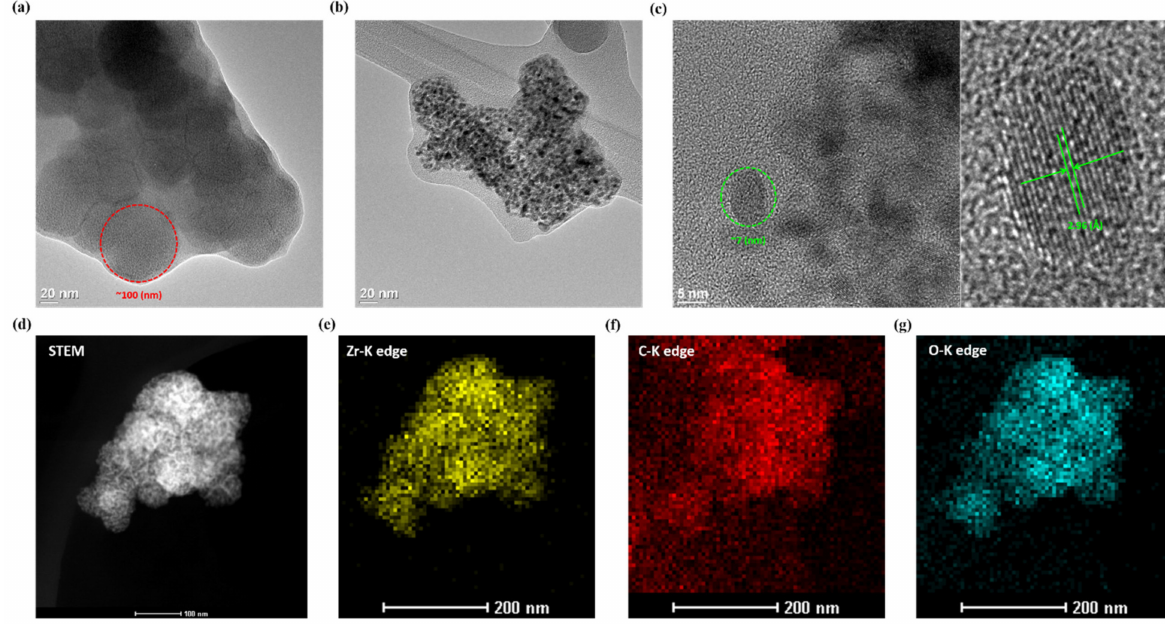
Figure 3. TEM images of ( a ) Zr-MOF and ( b ) MDC-900; ( c ) HRTEM images with enlarging one which is labeled d-spacing of MDC-900; the ( d ) HAADF-STEM image of MDC-900 and elemental mapping of ( e ) Zr-K edge, ( f ) C-K edge, and ( g ) O-K